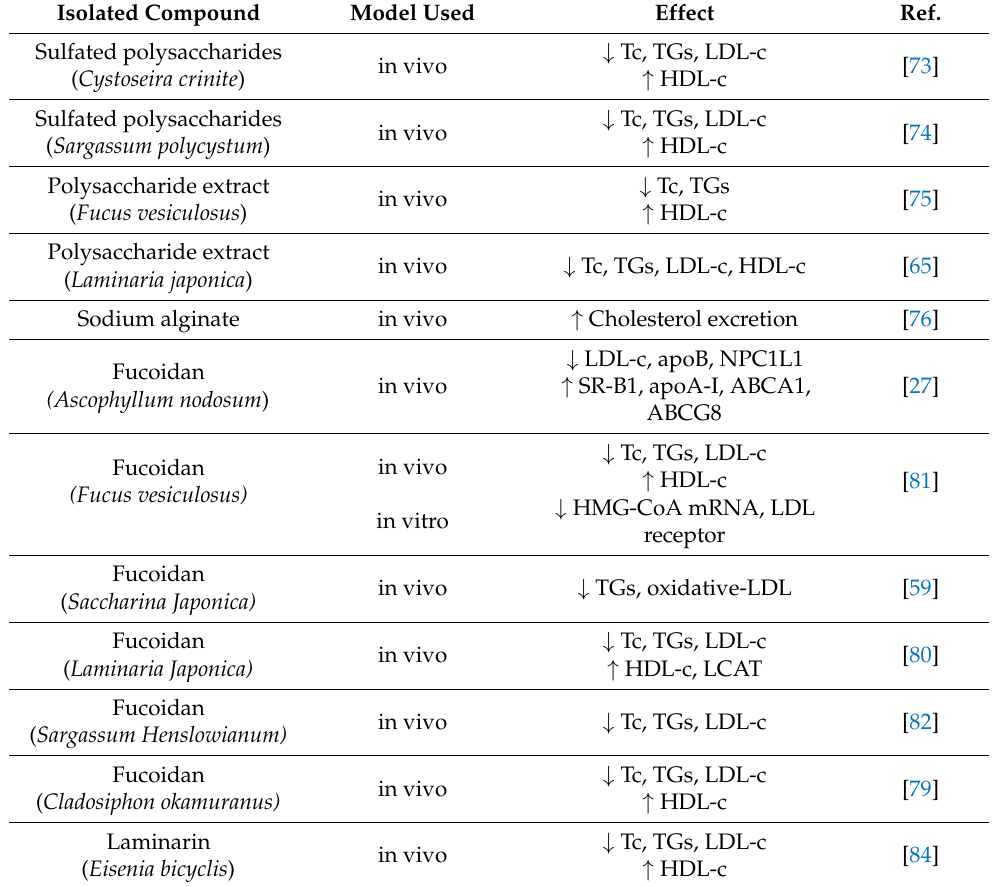
Table 3. Overview of the in vitro and/or in vivo hypocholesterolemic effect of polysaccharides isolated from different brown algae species under different extractions conditions.